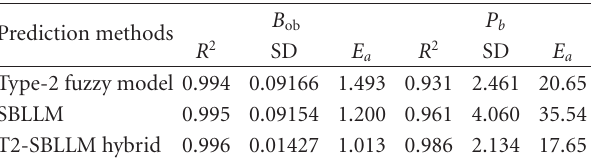
Table 1: Testing results for 160-dataset when predicting B ob and R 2 : correlation coe ffi cient, SD: standard deviation, E P b .